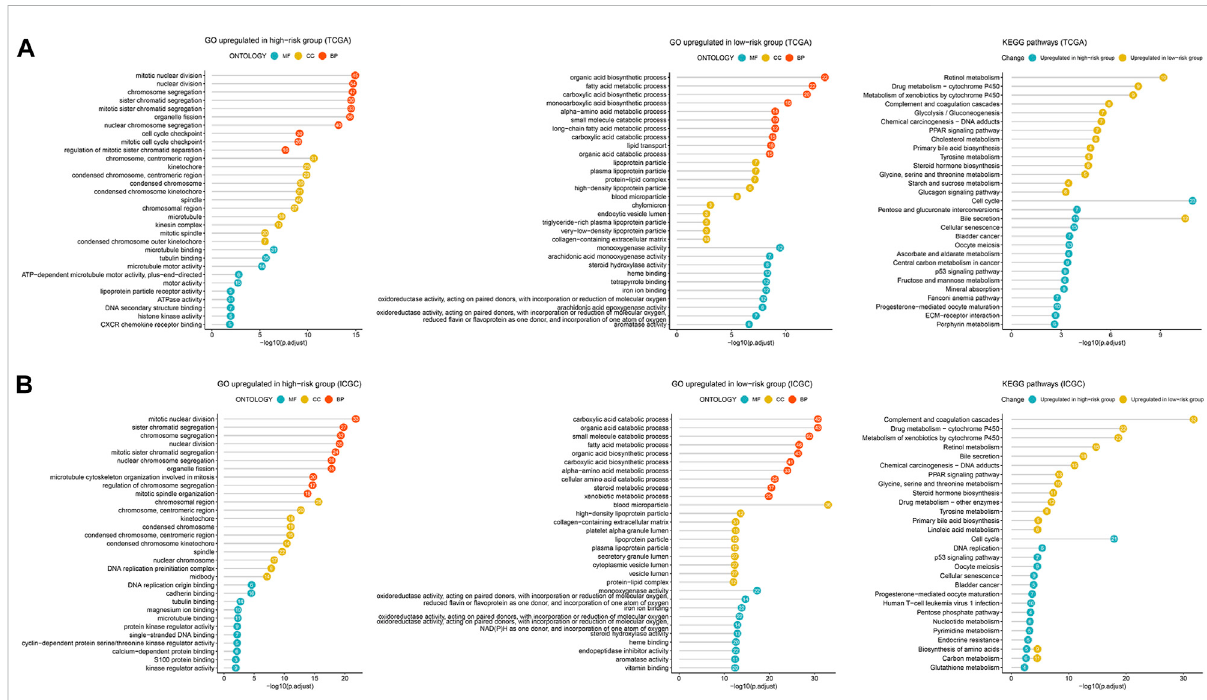
FIGURE 7 Enrichment analysis ofDEGsrelated tothe2-TFsignature. Themostsigni fi cantGO termsandKEGGpathways basedontheDEGsbetweenthe high- and low-risk groups in the TCGA cohort (A) and ICGC cohort (B) . DEGs, differentially expressed genes; GO, Gene Ontology; KEGG, Kyoto Encyclopedia of Genes and Genomes; TCGA, The Cancer Genome Atlas; ICGC, International Cancer Genome